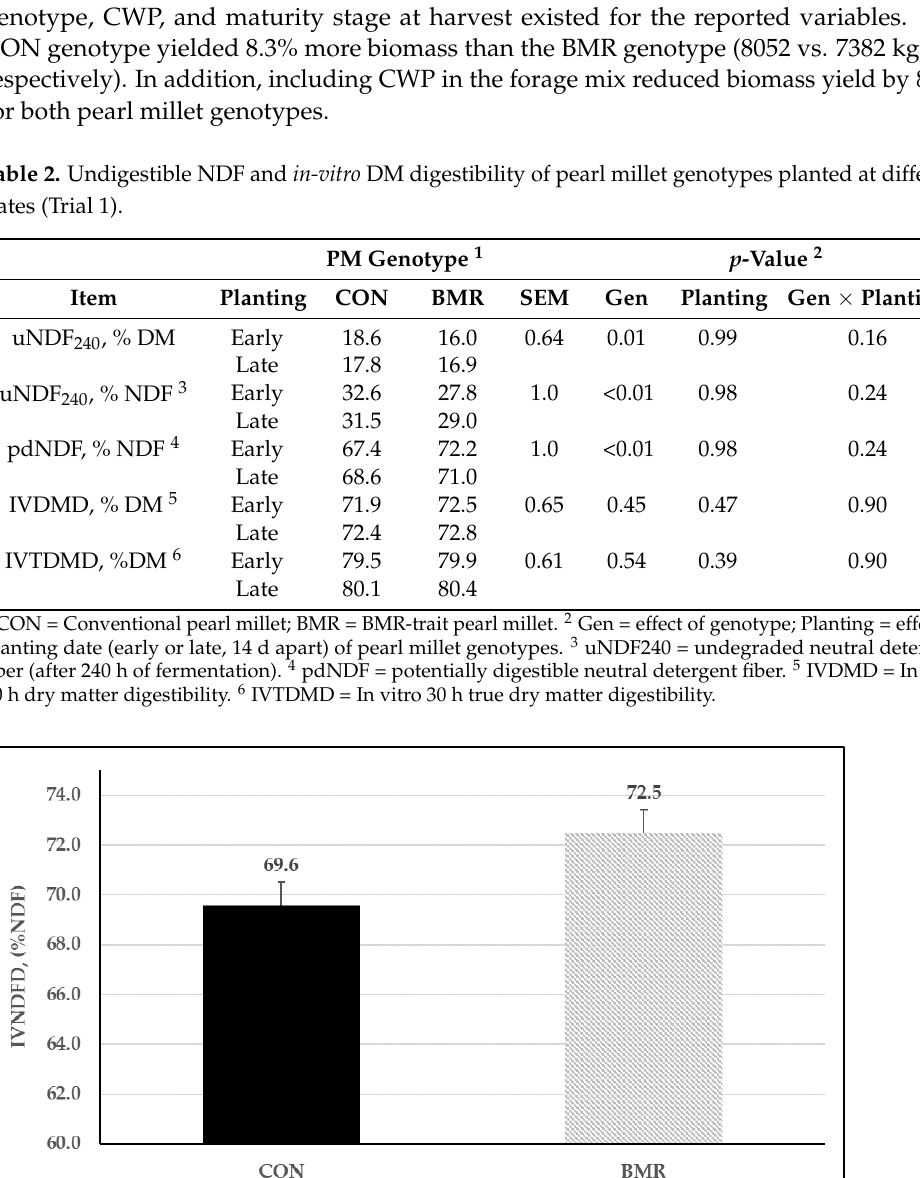
Figure 3. Potentially digestible NDF (pdNDF) yield per ha for Trial 1. Gen ( p = 0.75), planting date ( p < 0.01), and Gen × planting date ( p = 0.52); vertical bars indicate standard errors of the mean. We observed a significant effect ( p < 0.01) of harvest time on DM yield. The majority of the harvested biomass DM was obtained in the first and second harvest (58 and 33%, respectively) with a minor proportion (9%) of the total biomass yield collected in the last harvest of the growing season. Chemical composition was similar between the first and second harvest. However, relative to the first two harvests, the concentrations of ash, CP, and ADL were higher and the concentrations of aNDFom and ADFom were lower in the last harvest. In addition, the first harvest had the lowest (67.5%), the second harvest had the intermediate (70.7%), and last harvest had the highest (75.0%) IVNDFD ( p < 0.01). An interaction existed between genotype and harvest time for ADL ( p < 0.01) and IVNDFD ( p < 0.01). The BMR genotype had less ADL and ADL as a percentage of aNDFom concen- tration than the CON genotype in the first and second harvests but not in the last one, and IVNDFD followed the same response pattern. Trial 2. Table 3 presents the least squares means for the effects of pearl millet geno- types grown in monoculture or in mixture with CWP at different maturity stages at har- vest on biomass yield and forage nutritional composition. No interaction between pearl millet genotype, CWP, and maturity stage at harvest existed for the reported variables. The CON genotype yielded 8.3% more biomass than the BMR genotype (8052 vs. 7382